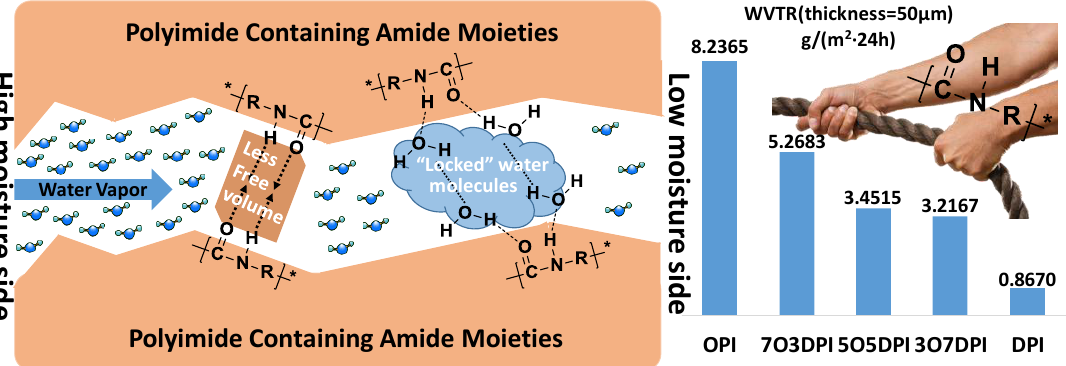
Figure 9. The barrier mechanism of the amide-containing polyimide films.